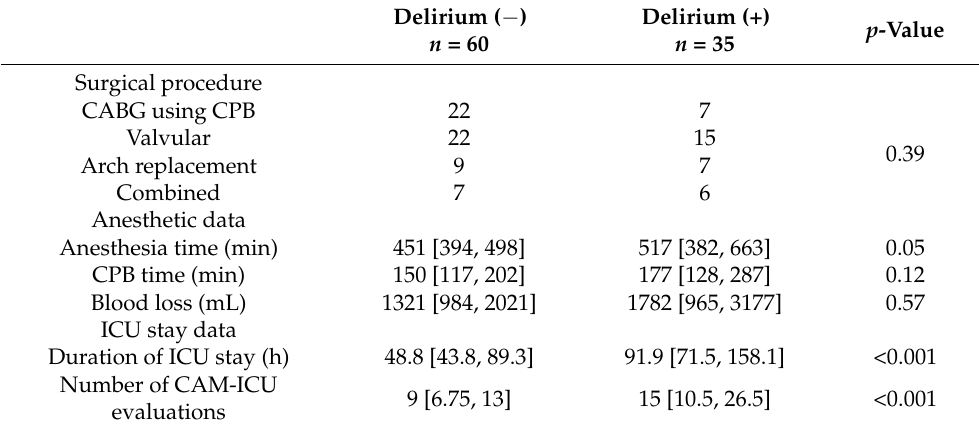
Table 2. Intraoperative and ICU stay data of the patients with and without postoperative delirium.